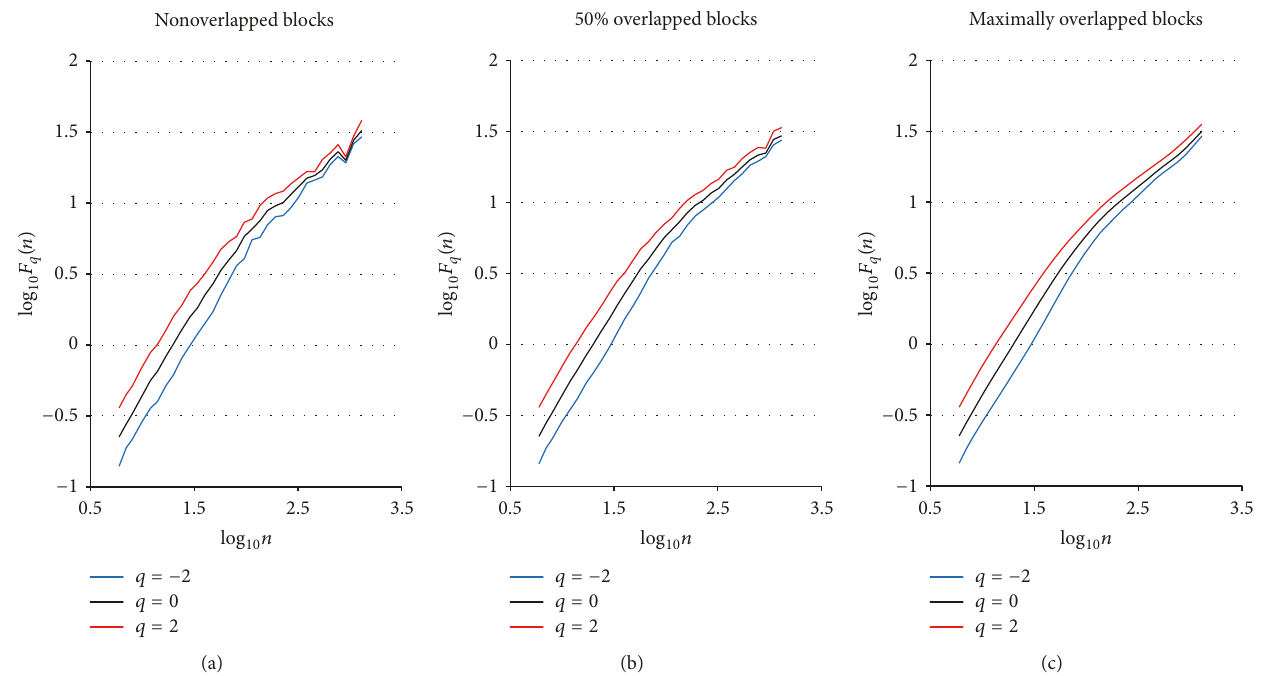
Figure 1: Examples of multifractal 𝐹 𝑞 (𝑛) functions plotted versus the block size n at different q values for nonoverlapped (a), 50 % overlapped (b), and maximally overlapped blocks (c) . Data from beat-to-beat IBI series of 2-hour duration recorded in a healthy volunteer sitting at rest.